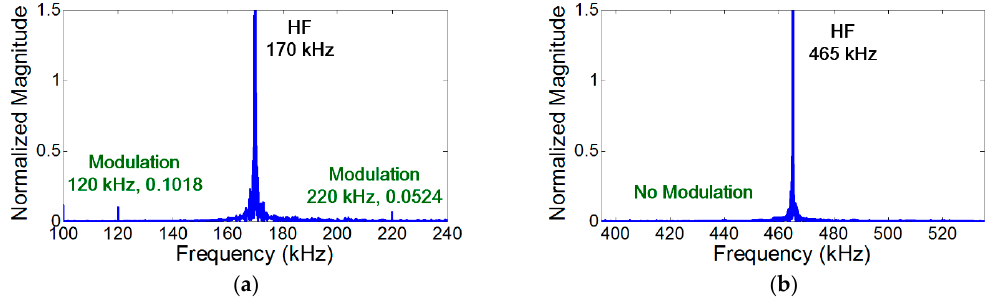
Figure 9. Experimental validation of the presence of the distributed material nonlinearity using the aluminum specimen without a fatigue crack. The modulation does not occur when the NCs for the distributed material nonlinearity are avoided. However, when the NCs for that are matched, the modulation components are generated without any fatigue crack. ( a ) NCs for the distributed material nonlinearity are matched (same with Figure 8b, without fatigue crack); ( b ) NCs for the distributed material nonlinearity are avoided (same with Figure 4a, without fatigue crack).